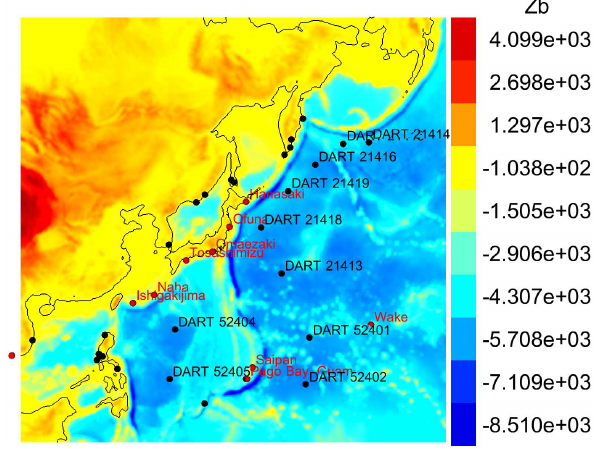
Fig. 2. Topography, analytical (lines) and numerical (symbols) wave profiles for the times indicated in the legend. The numeri- cal results are for l max = 14 i.e. a maximum spatial resolution of ≈ 3.6m. The numerical solution is represented using only one in every six discretisation points for clarity.